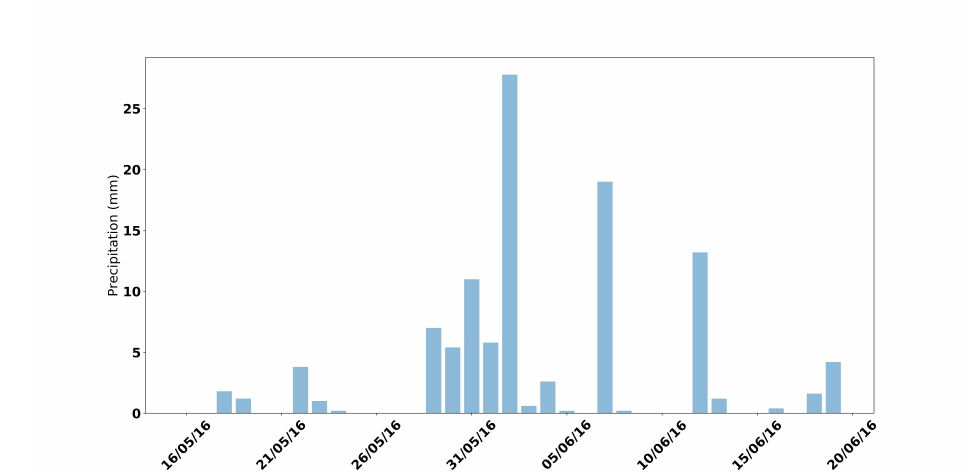
Figure 2. Daily precipitation measured in Weather Station Alken [14] leading to the flood event on 7 June 2016.